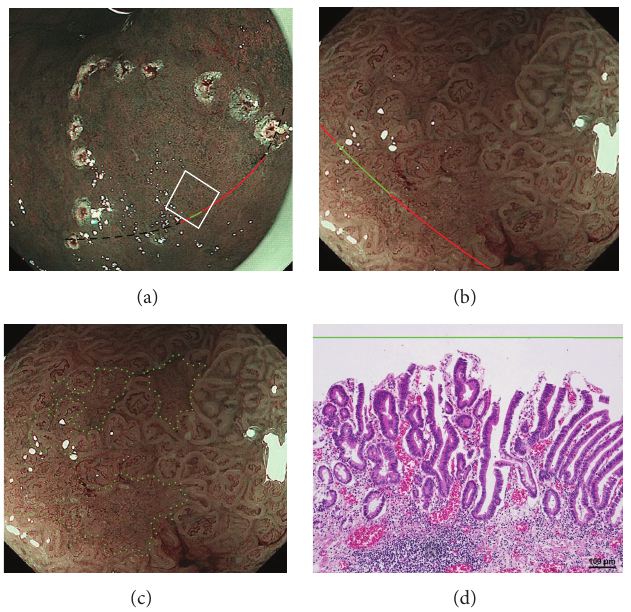
Figure 3: Endoscopic and histopathological findings of mixed-type- (M-), low-grade- (LG-), well-differentiated tubular adenocarcinoma (tub1) (M-LG-tub1). (a) Low-magnification view of narrow-band imaging magnifying endoscopy (NBI-ME) shows a superficial flat (0- IIb) lesion surrounded by cautery markings. The thin-broken, thin-solid, and thick-solid gentle curves show the one slice within the specimen resected by endoscopic submucosal dissection (ESD). The thin-broken, thin-solid, and thick-solid gentle curves indicate the noncarcinomatous part, the same carcinomatous part that is shown in (b), and the same carcinomatous part that is shown in (b) and (d), respectively. The slice was decided along with those gentle curves that changed into a single straight line linking two cautery markings because of being stretched out in the removed specimens. (b) High-magnification NBI-ME (boxed area in (a)). The thin-solid and thick-solid gentle curves show the same curves in (a) and (d). (c) The same view of (b) reveals another pattern that could not be classified into any of the four NBI-ME patterns (regular mesh pattern (RMP), loops within irregular polygonal and papillary structures (LIPPS), maze-like pattern (MLP), and ultra-fine granular pattern (u-FGP)) and LIPPS (surrounded by small-dotted lines and outside the lines, resp.) in a single lesion. This lesion had LIPPS, the aforementioned pattern, and RMP with loose mesh pattern (LMP) in different parts from this view and was diagnosed as mixed-type- (M-), low-grade- (LG-), well-differentiated tubular adenocarcinoma (tub1) (M-LG-tub1) (Figure 3(d)). (d) A post- ESD specimen presents a mixed-type- (M-), low-grade- (LG-), well-differentiated adenocarcinoma (tub1) (M-LG-tub1); the same part of the thick-solid gentle curve in (b) (within the area surrounded by small-dotted lines in (c)) is shown and the specimen exhibits a mixed lesion of low-grade, well-differentiated tubular adenocarcinoma (LG-tub1) with high-grade, well-differentiated tubular adenocarcinoma (HG-tub1) (Figure 3(d)). Histological examination corroborated the NBI-ME